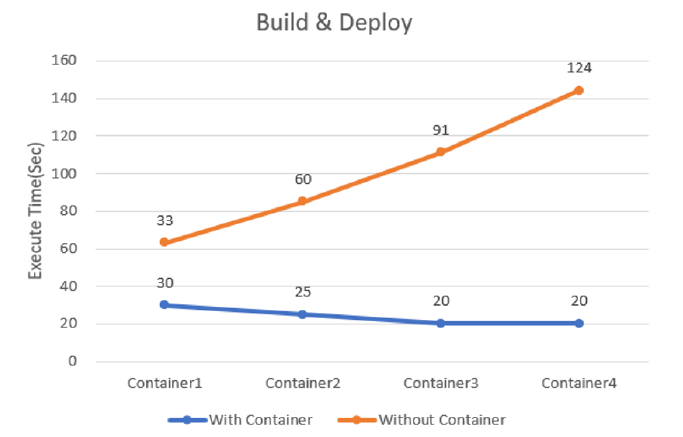
Figure 15. The Graph representations of execution times for builds and deployments with and without